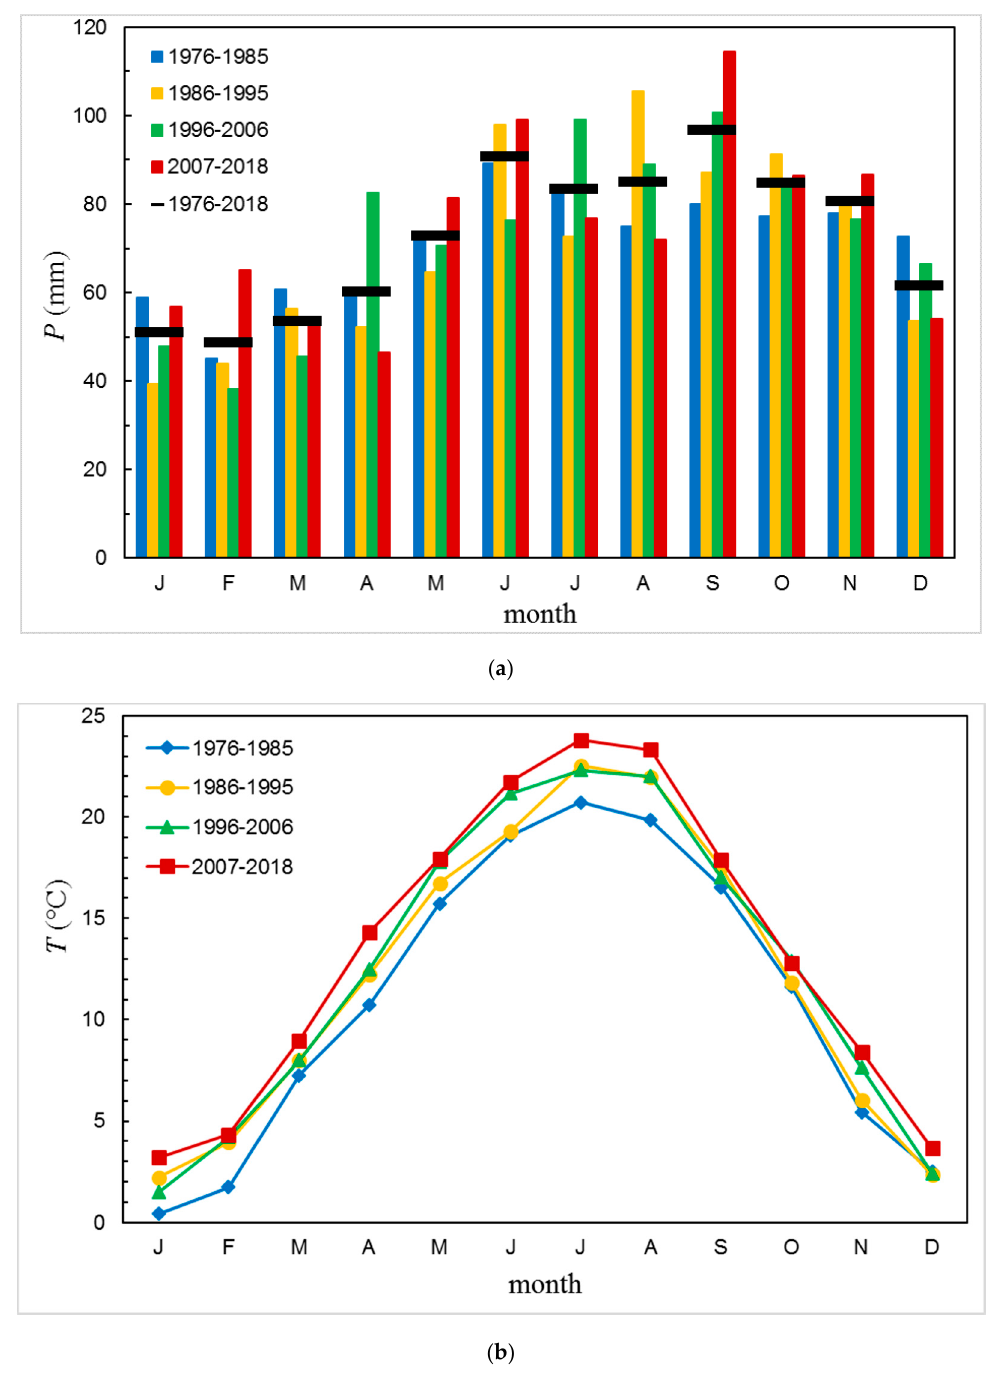
Figure 8. ( a ) Monthly mean precipitation amounts for the four subperiods and the average value for the whole period; ( b ) monthly mean air temperature for the subperiods.